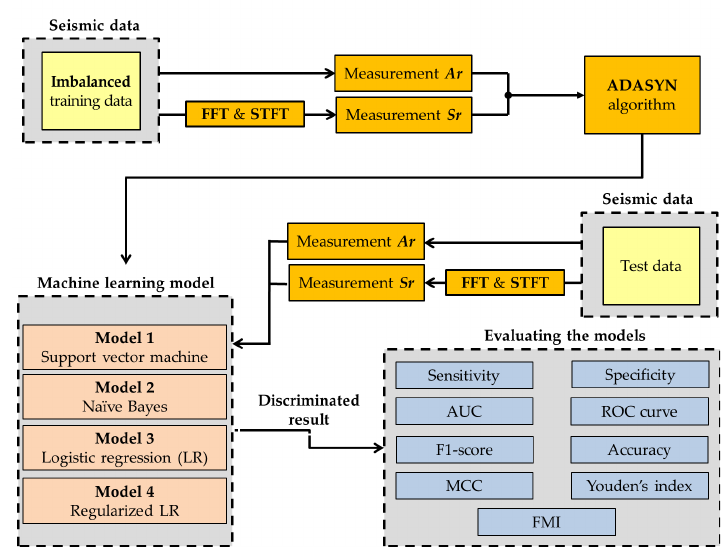
Figure 2. A flowchart of the proposed seismic